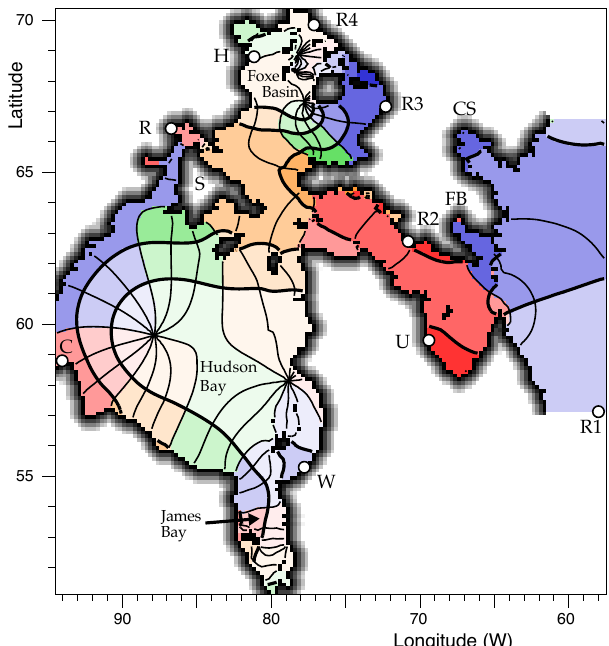
Figure 2. Model solution for the M2 tide. Thick lines are contours of amplitude at 0.5m, 1m, 2m and 3m. Thin lines are contours of phase, at intervals of 30 degrees, relative to the equilibrium tide at Greenwich. Colours denote phase quadrant (red, 0 ◦ –90 ◦ ; orange, 90 ◦ –180 ◦ ; green, 180 ◦ –290 ◦ ; blue, 270 ◦ –360 ◦ ) with the more in- tense colours denoting higher amplitudes. The tide gauge stations are C, Churchill; H, Hall Beach; R, Repulse Bay; W, Great Whale River; U, Hopes Advance Bay (Ungava Bay). Locations R1 to R4, S (Southampton Island), FB (Frobisher Bay) and CS (Cumberland Sound) are referred to elsewhere in the